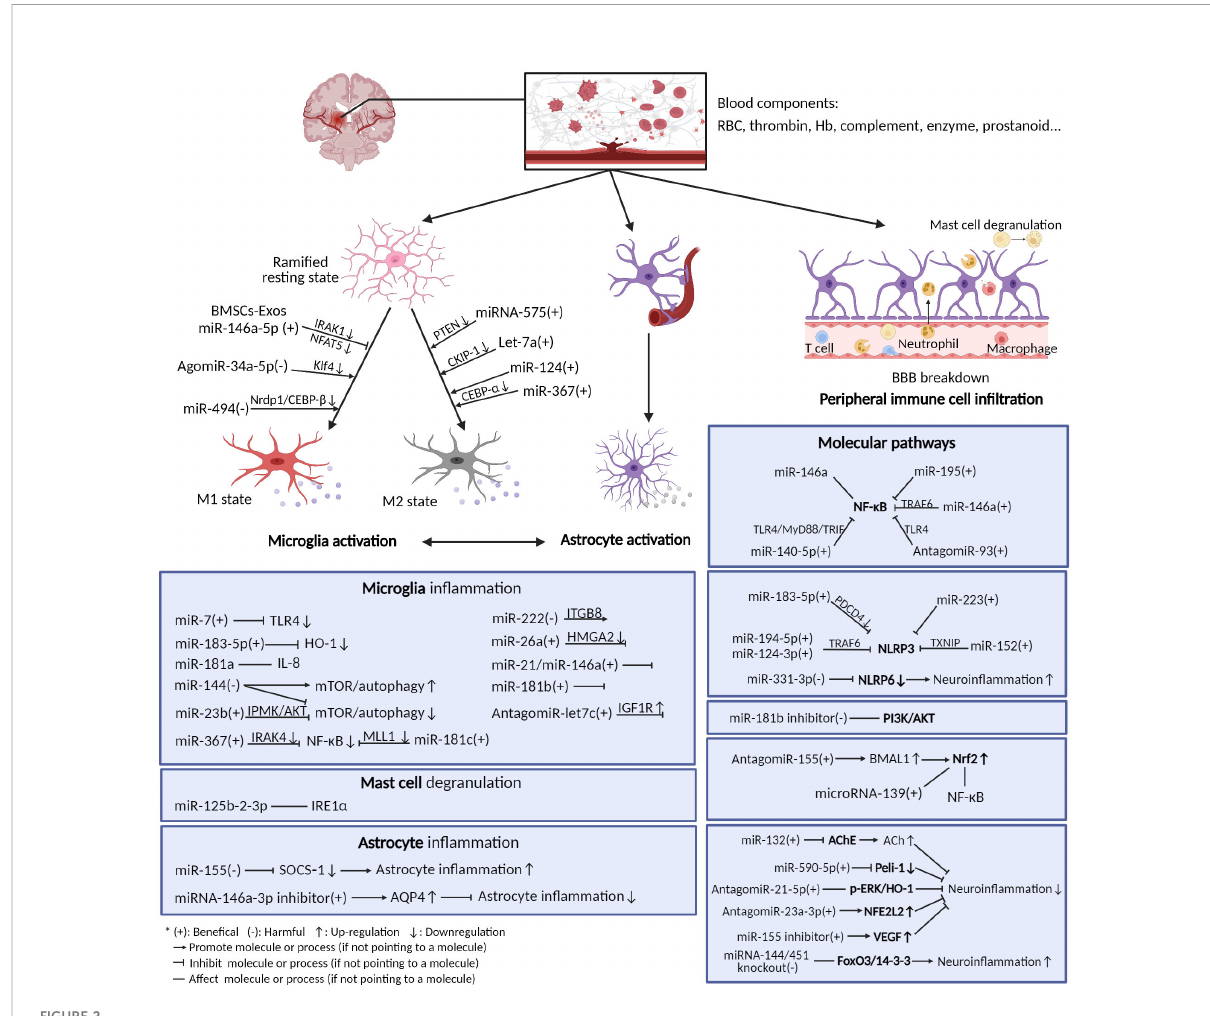
FIGURE 2 Neuroin fl ammation after ICH and microRNAs ’ modulation of it. After ICH, blood components extravasated from ruptured vessels activate resident immune cells in the brain (mainly microglia and astrocytes), thus triggering neuroin fl ammation. The immune cells release a variety of in fl ammatory mediators and activate diverse molecular pathways. Many miRNAs can exert functions on these cells and